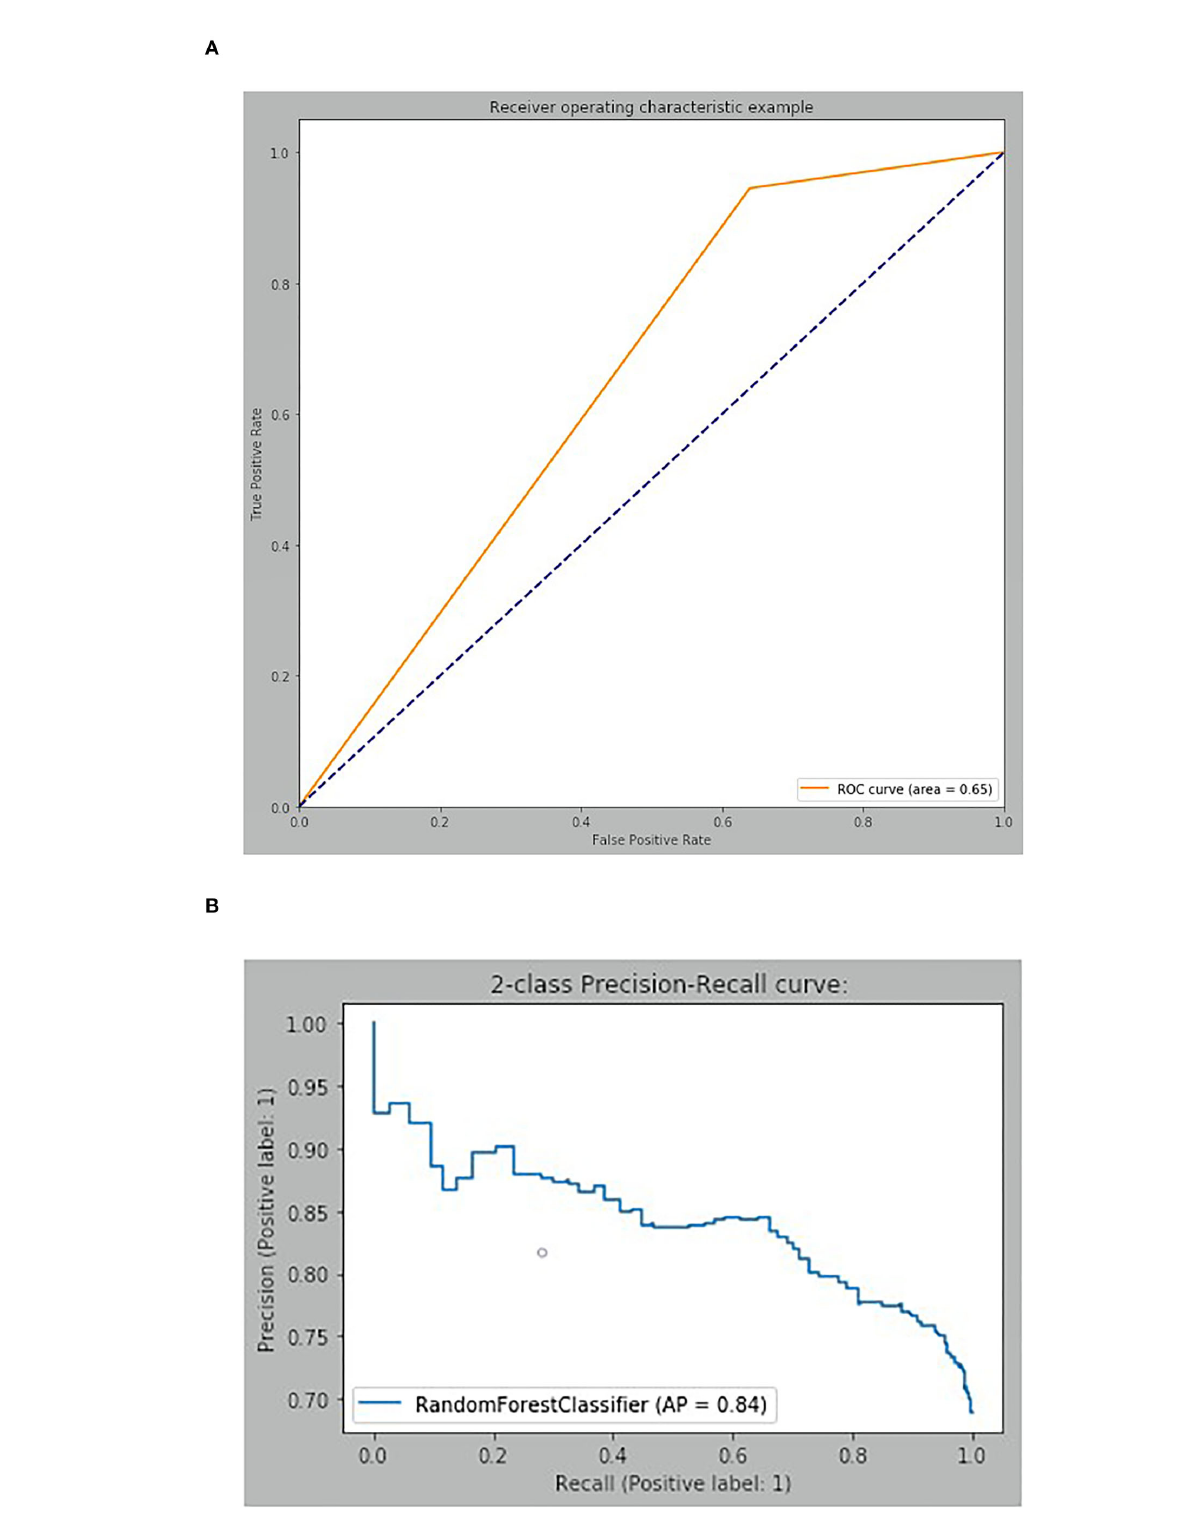
FIGURE4 Discriminatory ability of Random Forest Classifier. (A) Receiver operating characteristic curve. (B) Two-class Precision-Recall